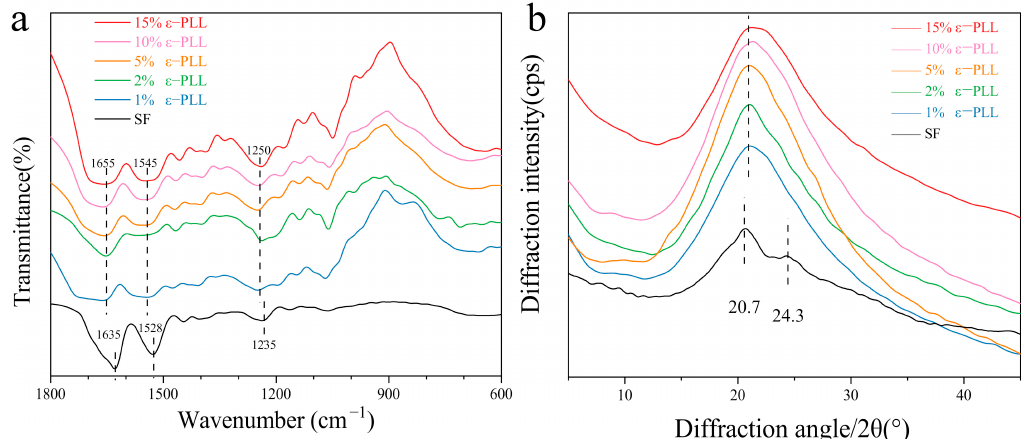
Figure 6. The structure of SF hydrogels: ( a ) FTIR absorption spectra; ( b ) X ray diffraction curves. (The solid content of SF and CSF solution is 3 wt.%, HRP concentration is 10 U/mL, H 2 O 2 concentration is 1 mM).